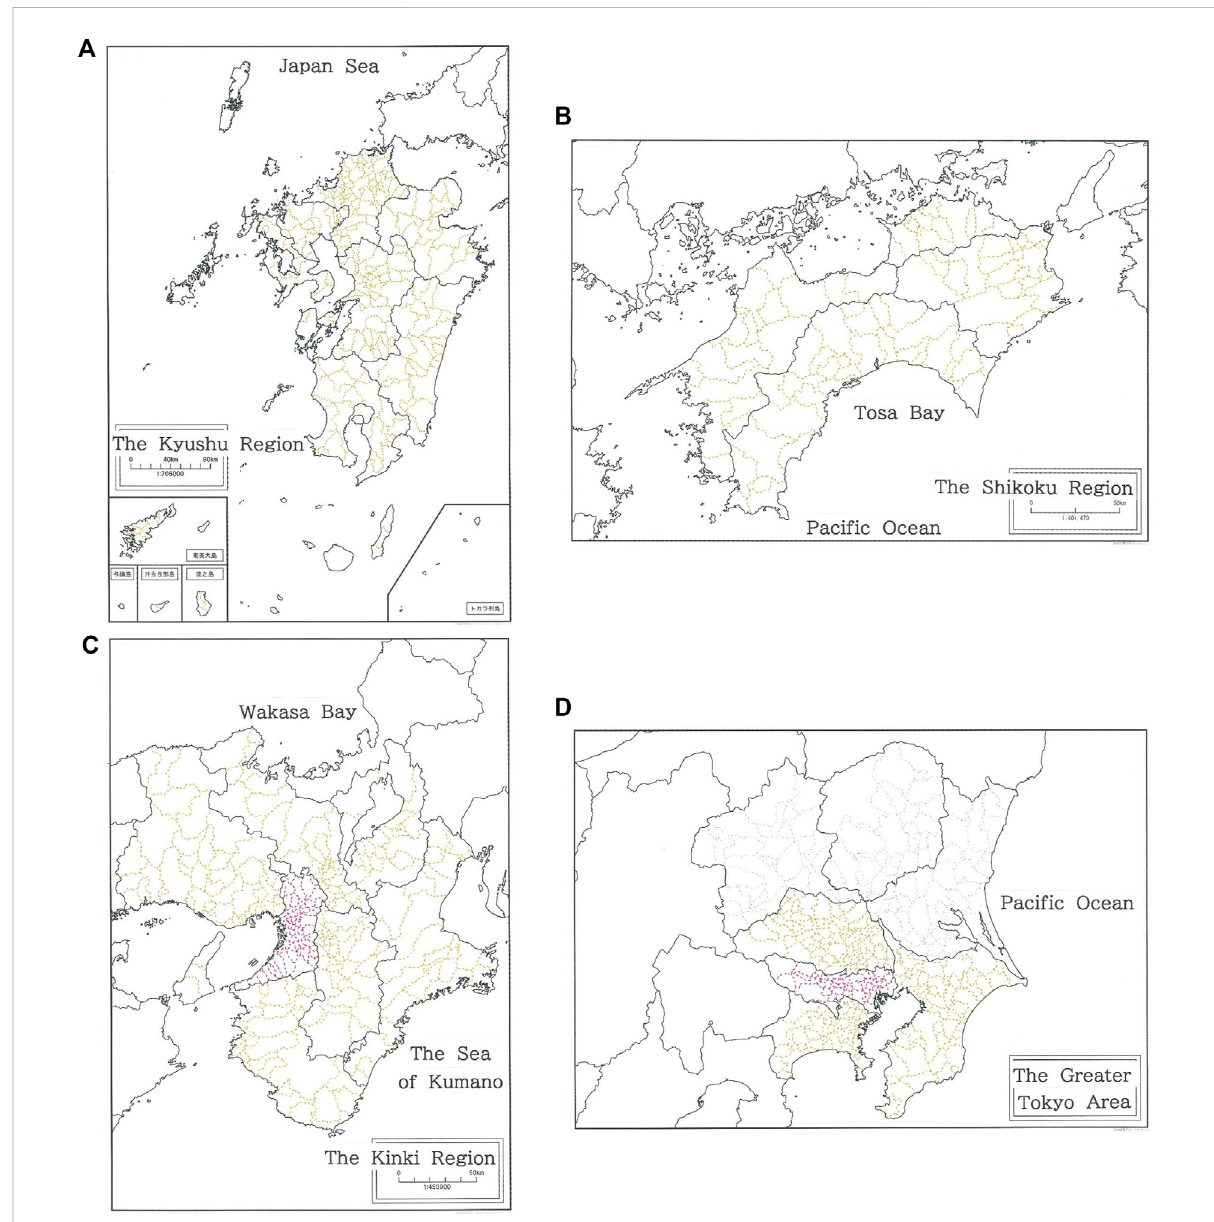
FIGURE 12 A complete map of the (A) Kyushu Region (B) Shikoku Region, (C) Kinki Region, and (D) Greater Tokyo Area (GTA). The colored dashed lines in (A – D) indicate the boundaries among municipalities in the